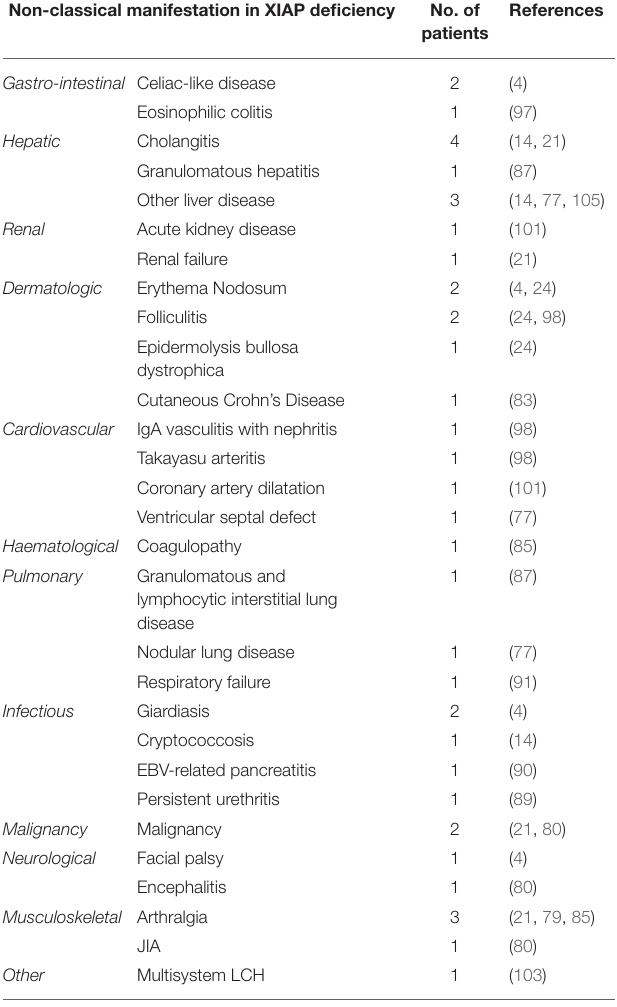
TABLE 2 | Overview of infrequent disease manifestations that have been described in XIAP deficient male patients. Non-classical manifestation in XIAP